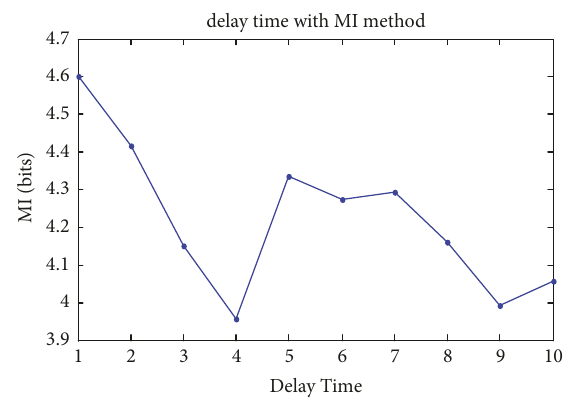
Figure 4: Selection of the delay